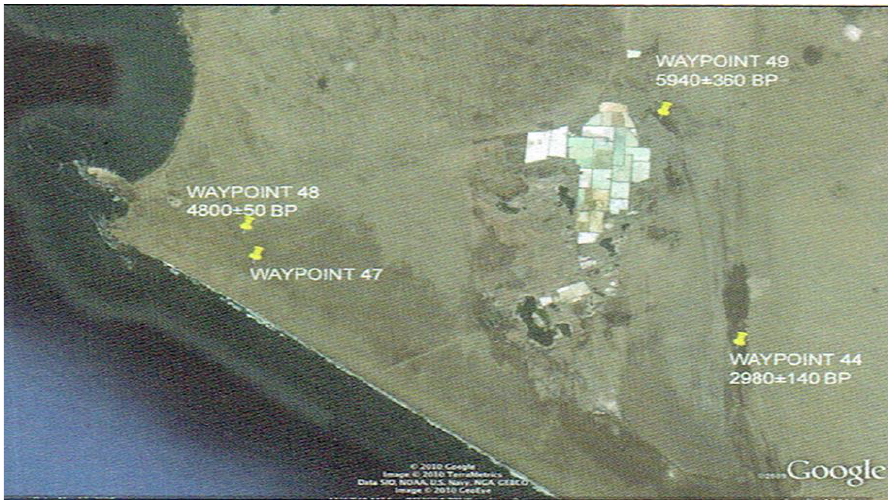
Figure 26. Coastal area landscape changes over time. Color version of figure derived from [2], p. 228.